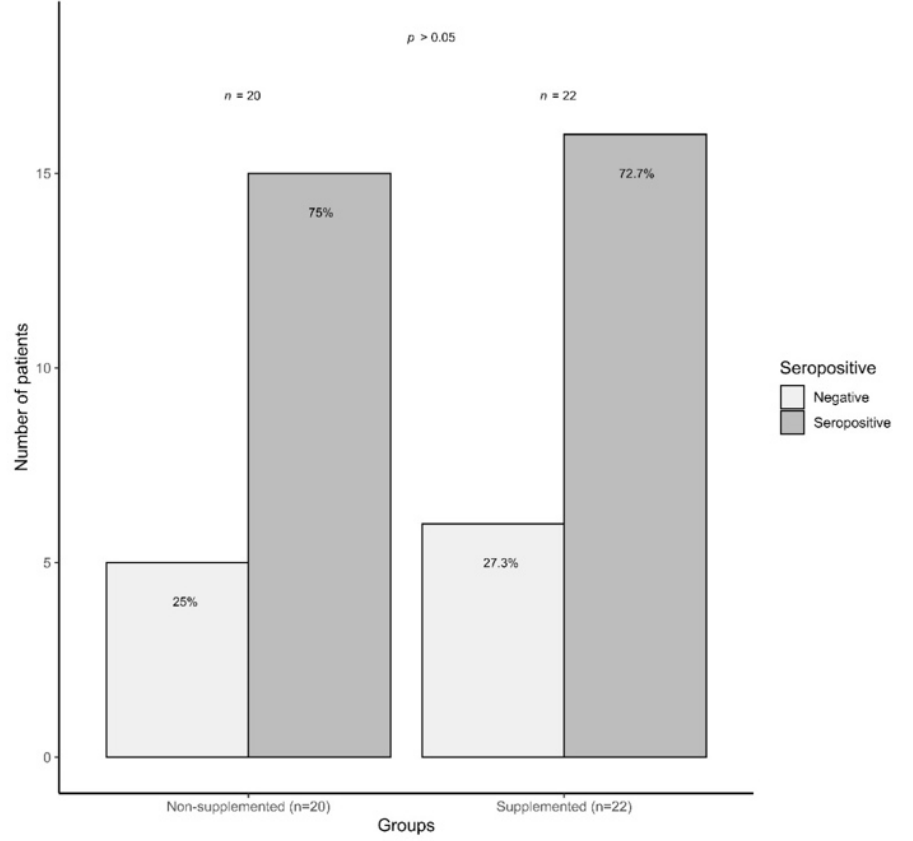
Figure 3. COVID-19 outpatients seropositivity rate (IgM and/or IgG) at day seven. The graph shows the percentage of seropositive (dark gray color) and seronegative (light gray color) outpatients, supplemented and not supplemented with vitamin D3 on day seven. Results obtained by a lateral flow immunoassay method (rapid qualitative test Certum 2019-nCov IgG/IgM). n supplemented = 22, n non-supplemented = 20.